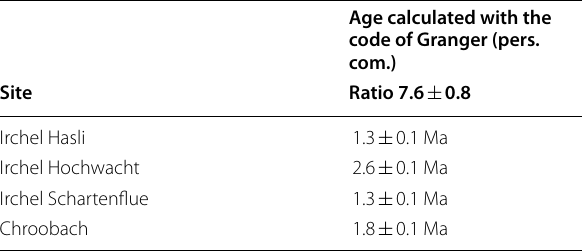
Table 3 Calculated isochron-burial ages for the four sites using an initial ratio of 7.6 ± 0.8